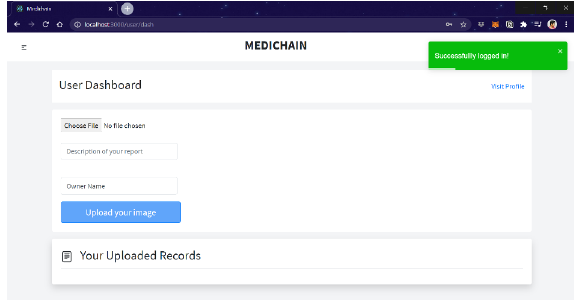
Figure 4. User Dashboard